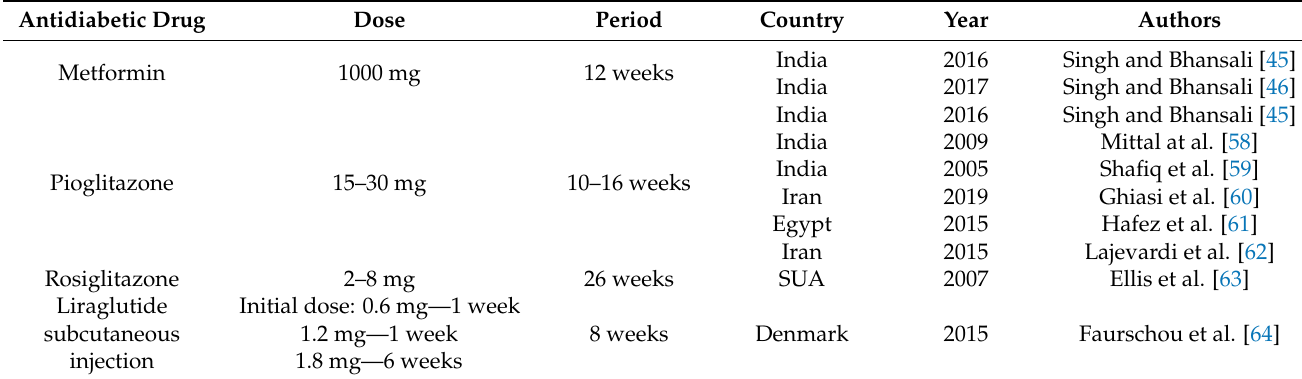
Table 4. Antidiabetic drugs used in patients with psoriasis [45,46,57–64]. Antidiabetic Drug